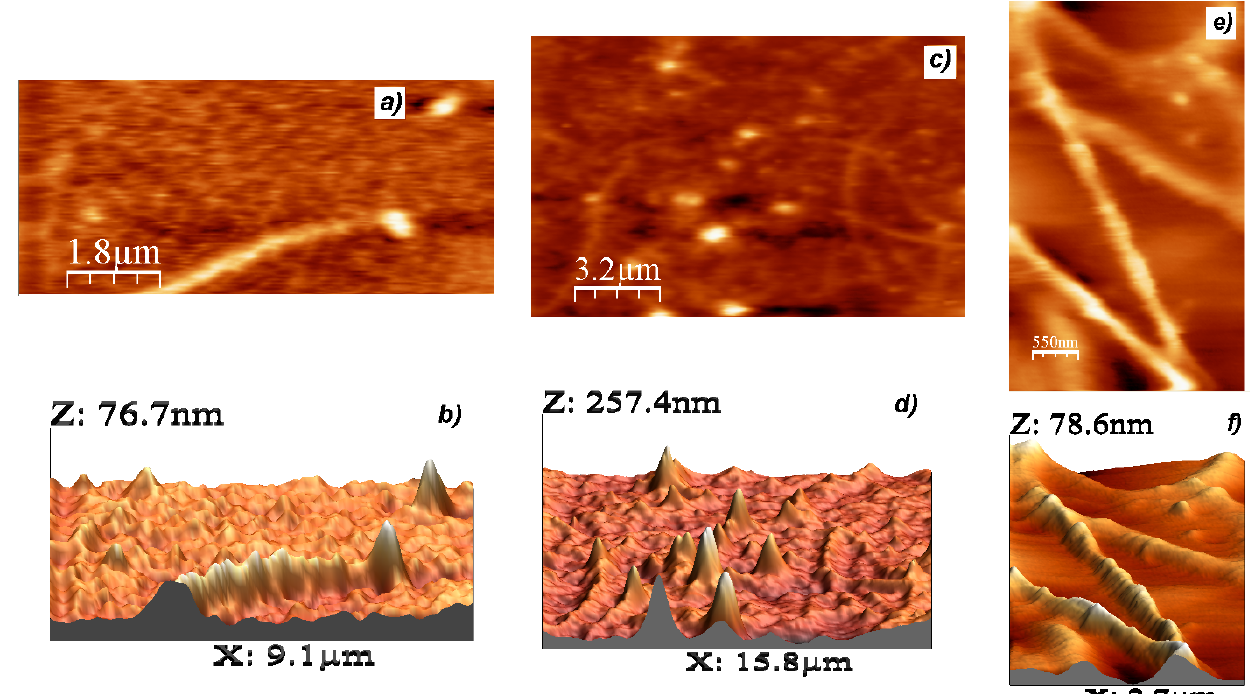
Figure 2. Atomic Force Microscopy (AFM) images of P3HT film with multi-wall carbon nanotubes (MWNTs) included. (a , c , e) 2-Dimensional image showing the nanotubes buried in the polymer matrix. (b , d , f ) 3-Dimensional image highlighting the nanotubes ends coming out of the polymer matrix left and the nanotubes emerging at the surface of the